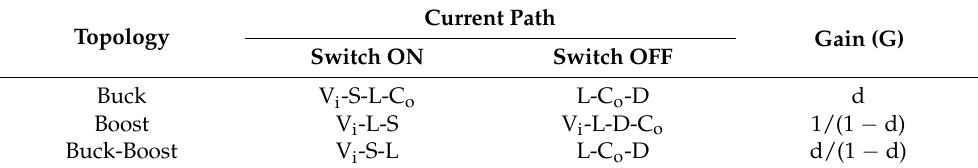
Figure 1. Circuit diagram: (a) buck; (b) boost; (c) buck-boost. Table 1. Current path and gain in topologies.